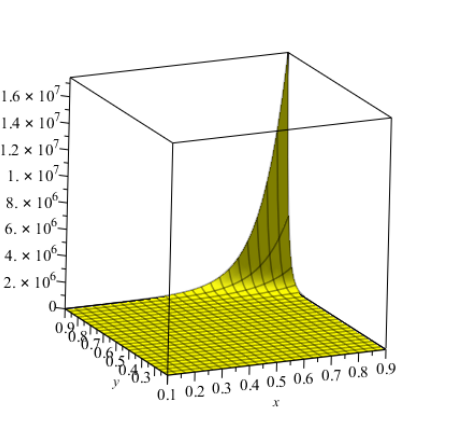
Figure 6: Graphical Representation of Forgotten polynomial of hex-derive network HDN 2( n )